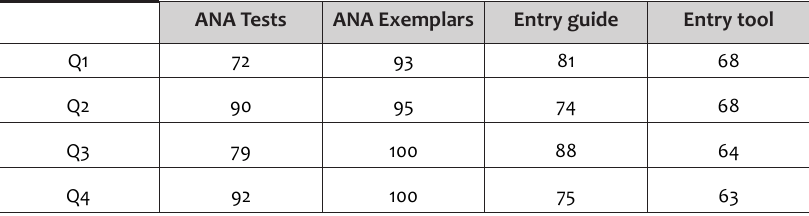
Table 2: Receipt of relevant documentation by quintile category ANA Tests ANA Exemplars Entry